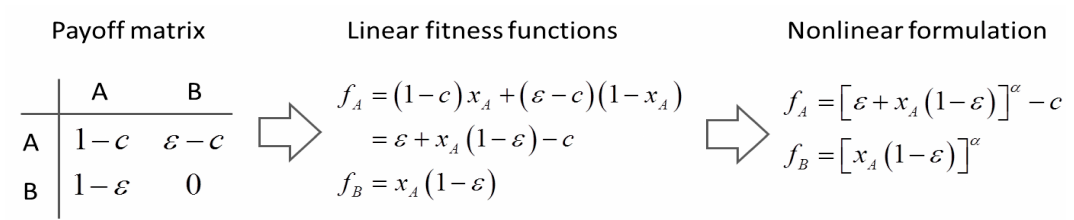
Figure 8. Linear and nonlinear fitness functions derivable from the payoff matrix for the system considered by Gore et al.